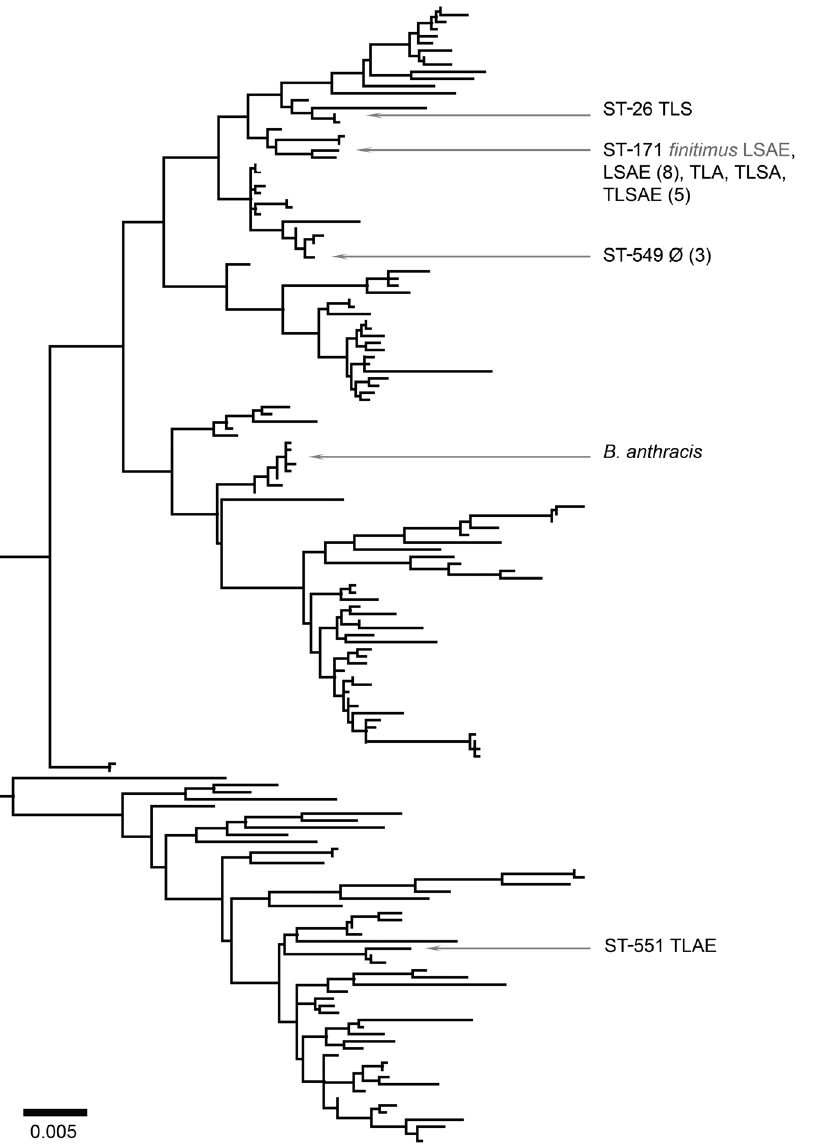
Figure 1. Un-rooted maximum likelihood analysis of Clade 1, with sequence types and corresponding phenotypes found in our sample indicated. Numbers in parentheses indicate the number of isolates with the indicated phenotype observed in the ST. Light text indicates varieties and phenotypes described by de Barjac [3]; B. anthracis added for reference.